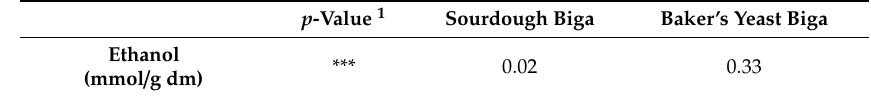
Table 2. Cont. p -Value 1